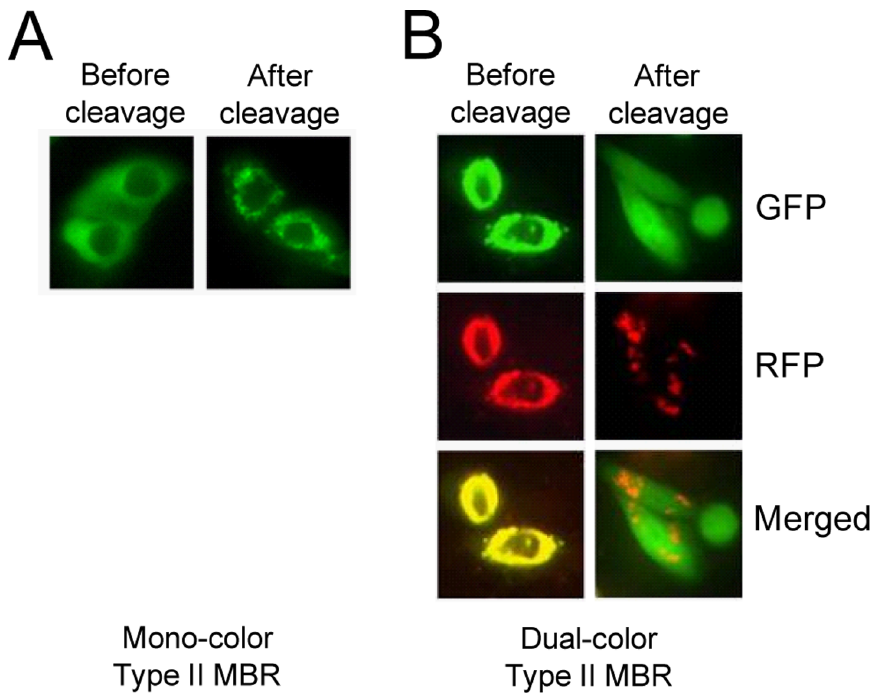
Figure 3. Detection of HCV NS3 protease using type II MBRs. Type II MBRs were constructed to contain a mitochondrial targeting sequence, MSRA as a masked translocation signal. The masking protein used was GAPDH or GFP for mono- or dual-color type II MBRs, respectively. A . Cleavage of mono-color type II MBR by HCV NS3 protease activates the mitochondrial translocation signal of MSRA, resulting in translocation of GFP from the cytosol (before cleavage) to the mitochondria (after cleavage). B . Cleavage of dual-color type II MBR which contains both GFP and RFP, results in translocation of the RFP from the cytosol (before cleavage) to mitochondria while GFP remains in the cytosol (after cleavage) following cleavage. GFP; green fluorescent protein, RFP; red fluorescent protein.